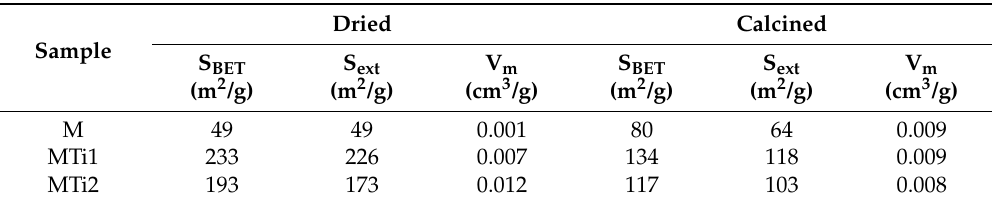
Table 4. Specific surface area (S BET ), external surface area (S ext ) and micropore volume (V m ) of natural montmorillonite [24] and of the